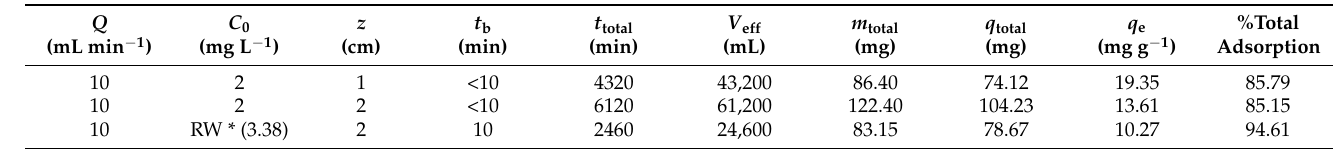
Table 3. Influence of column height on experimental breakthrough parameters for phosphate adsorp- tion by monolithic